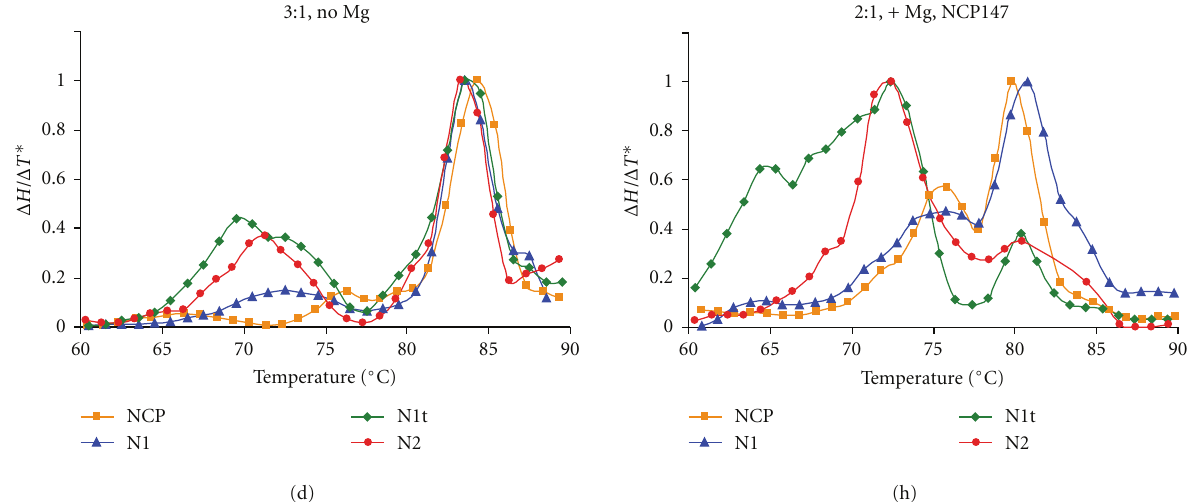
Figure 4: Thermal denaturation assays reveal influence of divalent metal and HMGNs on nucleosome stability. ((a)–(h)) Sample bu ff er was near physiological ionic strength without divalent metal ((a)–(d); 1XTB, default) or with 1mM Mg 2+ or Ca 2+ ((a)–(c), (e)–(h); +Mg, +Ca). Assays were conducted on naked NCP DNA fragments alone (a), NCP ((b), (c)), NCP-601 with 3:1 HMGN :NCP stoichiometry in the absence of divalent metal (d), NCP-601 with 1:1 (e), 2 :1 (f), or 3: 1 (g) HMGN :NCP stoichiometry and NCP147 with 2: 1 HMGN :NCP stoichiometry (h). ((d)–(h)) “NCP” corresponds to an HMGN-free control